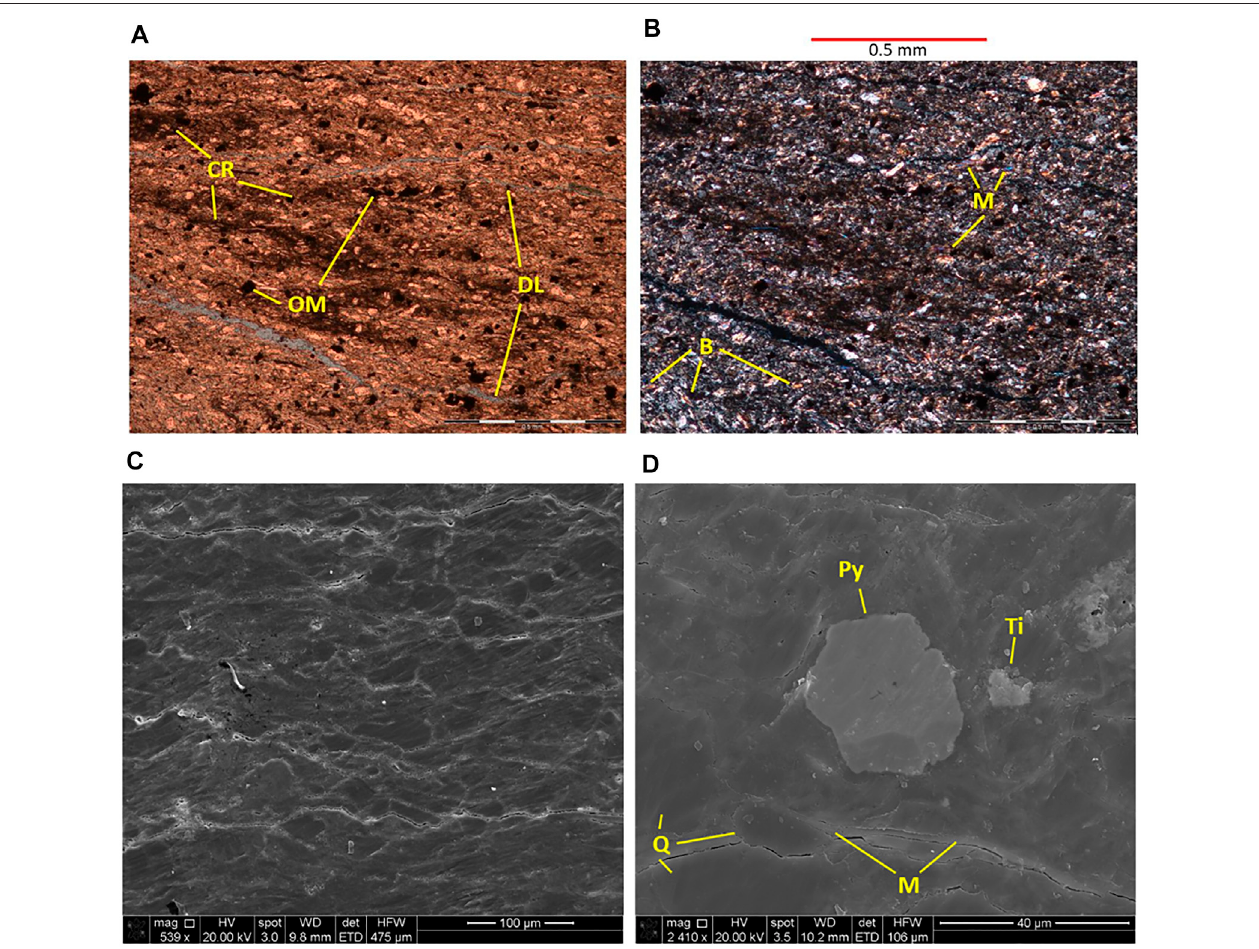
FIGURE 7 | Thin section of the massive mudstone facies in the Paluxy Formation, MPC 34-1 well, 1,617.1 m (5,305.5 ft). (A) PPL photomicrograph showing clay- rich lenses (CR), organic matter (OM), and fi ssures or delamination (DL) along bedding. (B) CPL photomicrograph showing abundant muscovite (M) and less common biotite (B) grains.SEMimageofthemassivemudstonefaciesimagedperpendiculartobedding,fromthePaluxyFormationMPC34-1well,5,305.6 ft. (C) Thereisalack of authigenic pores. (D) SEM/EDS image showing muscovite (M) parallel to bedding, pyrite (Py), quartz (Q), and an accessory mineral rich in titanium (Ti), possibly rutile or